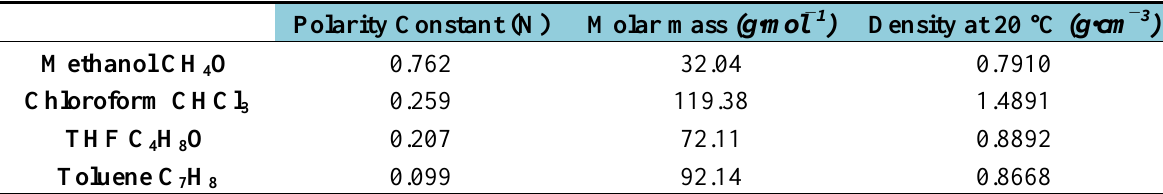
Table 2. Solvent characteristics.